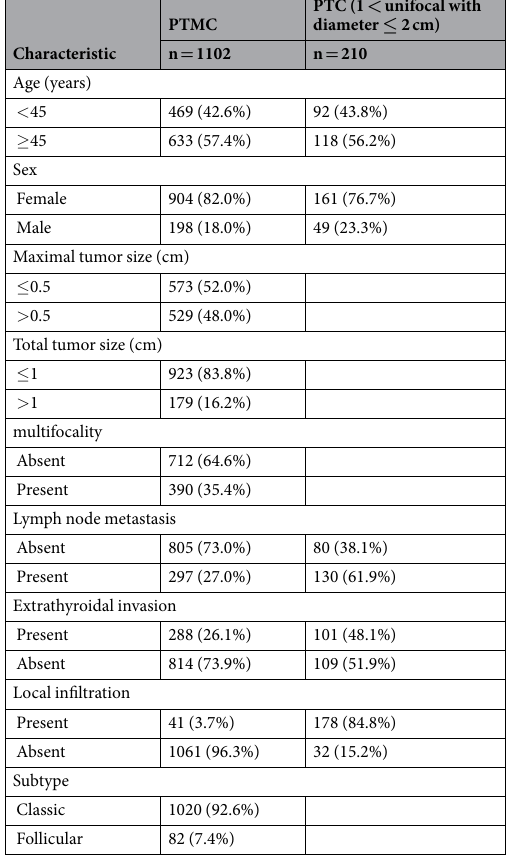
Table 1. Basic clinicopathological characteristics of the papillary thyroid microcarcinoma patients (n = 1102) and papillary thyroid carcinoma (1 < unifocal with diameter ≤ 2 cm) (n = 210). PTMC: papillary thyroid microcarcinoma. PTC: papillary thyroid carcinoma.